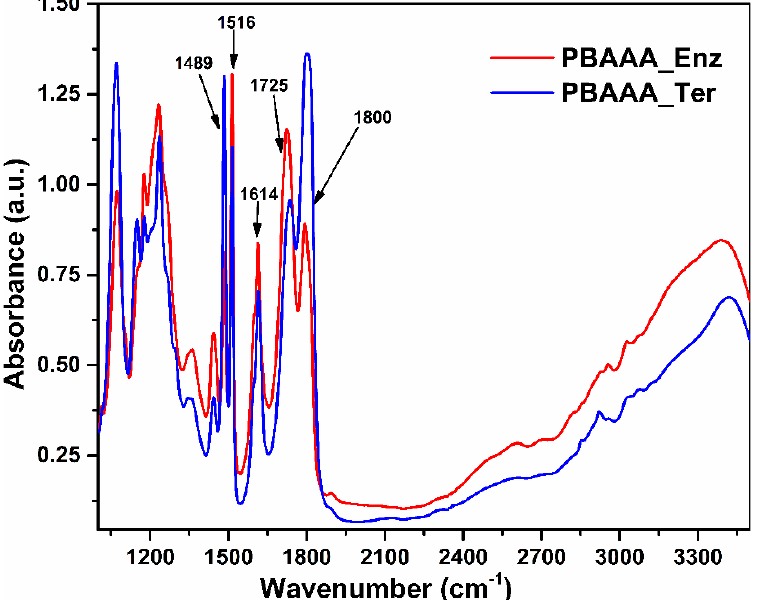
Figure 3. FTIR spectra of PBAAA_Enz and PBAAA_Ter collected between 400 and 4000 cm − 1 using 1.92 mg of the sample as pressed pellets embedded in KBr. Table 1. Relative contributions (%) of the C=O unit of polymer PBAAA_Ter versus PBAAA_Enz . Polymer